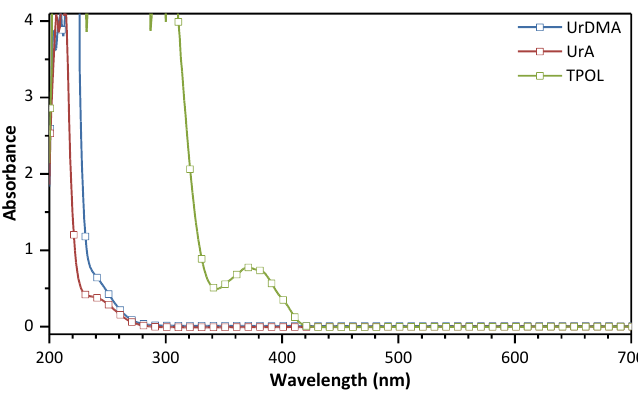
Figure 1. UV-vis spectra for UrDMA, UrA, and TPOL in acetonitrile solution (0.8 g/L). Figure 1. UV–vis spectra for UrDMA, UrA, and TPOL in acetonitrile solution (0.8